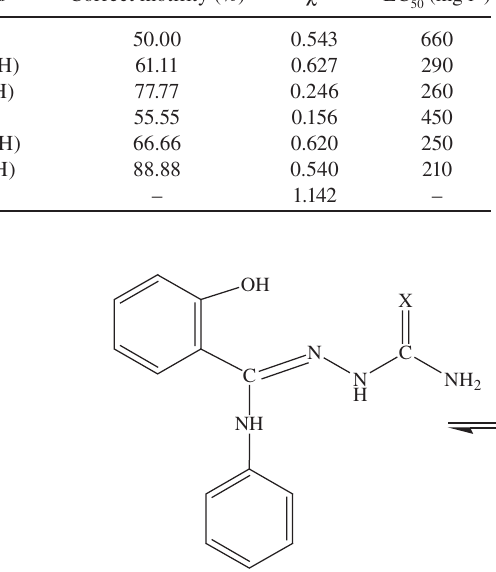
Table 6 Pesticidal data of ligands and their metal complexes. Compound